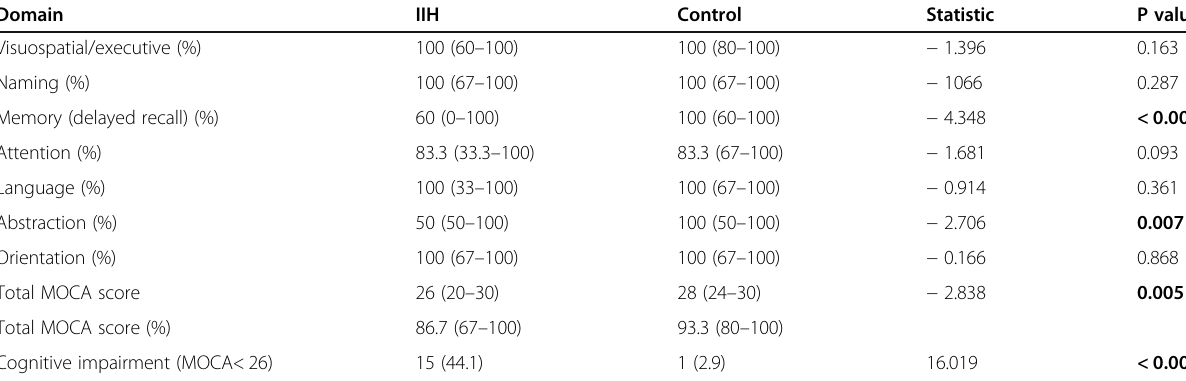
Table 5 MOCA components and cognitive impairment in patients and control Domain IIH Control Statistic P value Visuospatial/executive